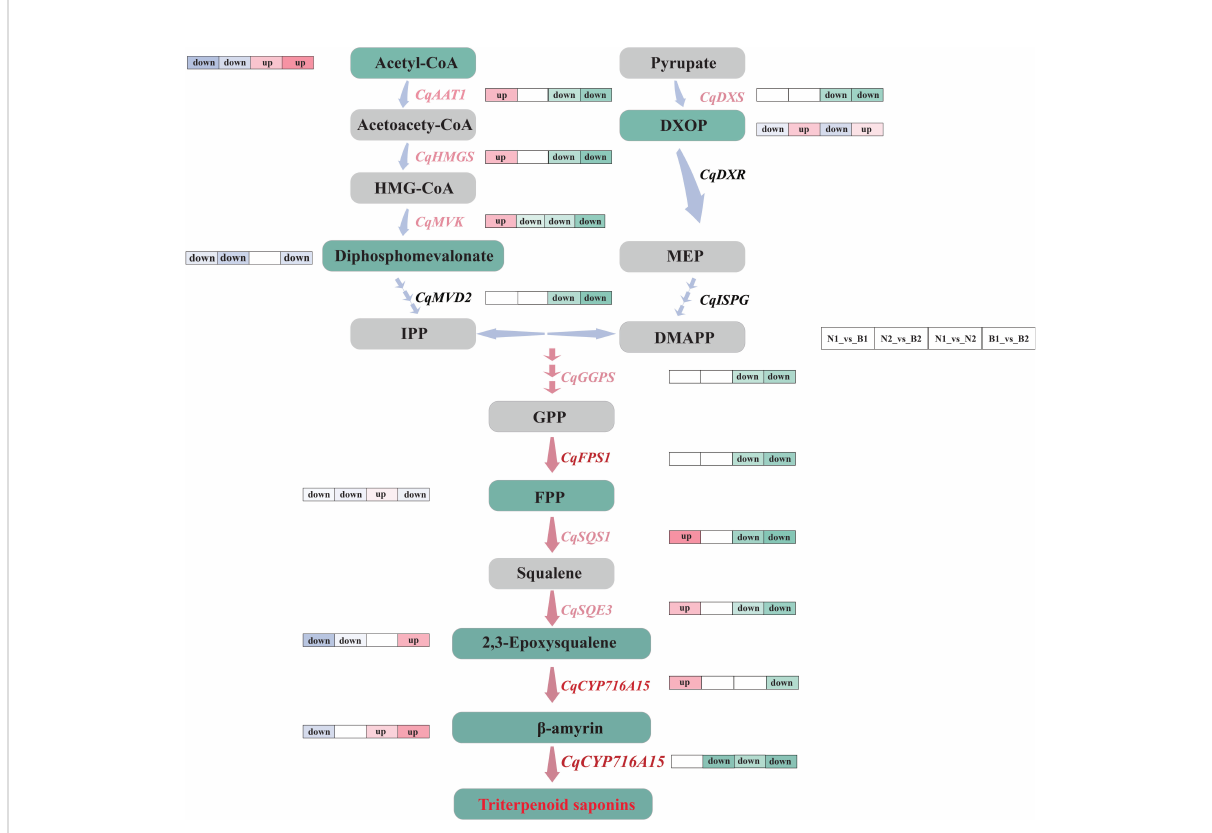
FIGURE 6 Flow-processing chart of the triterpenoid saponin (TS) biosynthesis in quinoa. The light blue and pink arrows between the metabolites indicate the upstream and downstream metabolic pathways. The labels next to the blue arrows are differentially expressed genes (DEGs), in which the key DEGs are labeled with pink. The gray and green rectangles represent the normal and key differentially accumulated metabolites (DAMs). The label “ up ” next to the genes and metabolites represents the upregulated key candidate DEGs and key DAMs in N1_vs_B1, N2_vs_B2, N1_vs_N2, and B1_vs_B2 comparison groups, and the label “ down ” next to the genes and metabolites represents the downregulated key candidate DEGs and key DAMs. The pathways marked by pink arrows are the key parts during the TS biosynthesis in